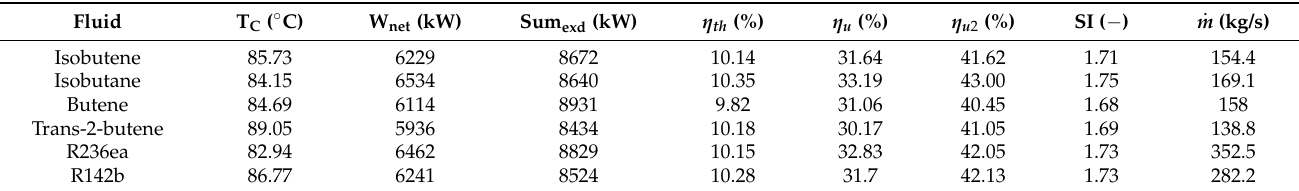
Table 4. Optimized model for different working fluids for 10 ◦ C pinch point for the simple ORC model.